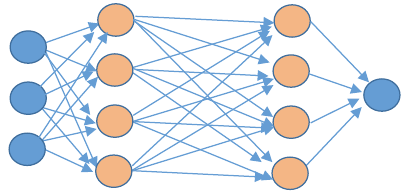
Figure 4: An example of RNN architecture [29, 30].